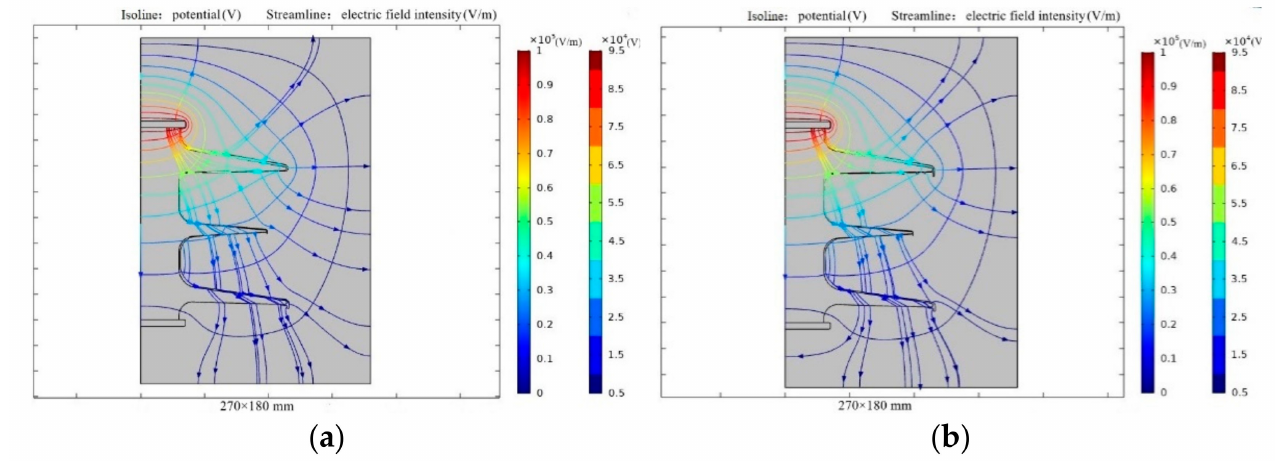
Figure 4. Simulation results of electric field distribution. ( a ) simulation results without water-film and water-drops on shed surface; ( b ) simulation results with water-film and water-drops on shed surface.